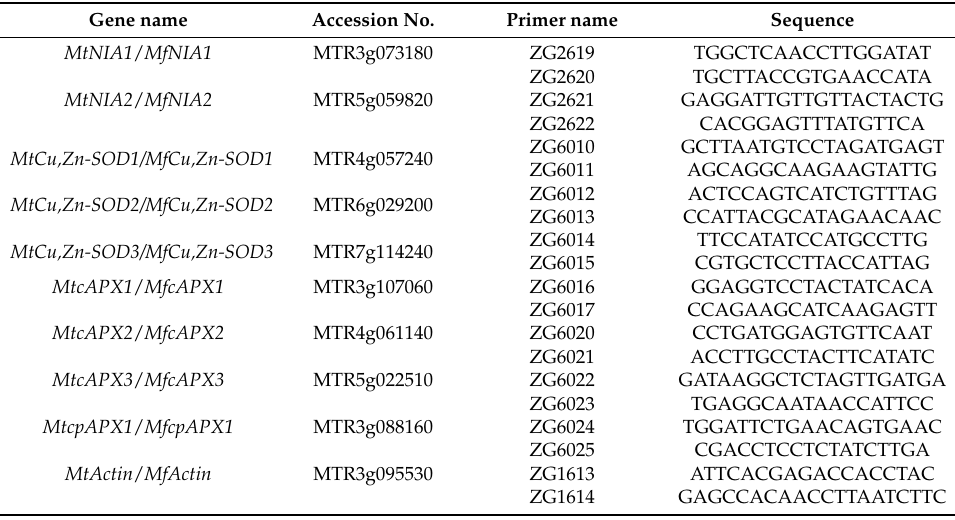
Table 1. Primers used for real-time quantitative PCR